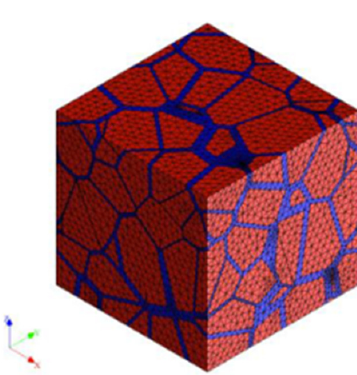
Figure 7. Porous RVE.